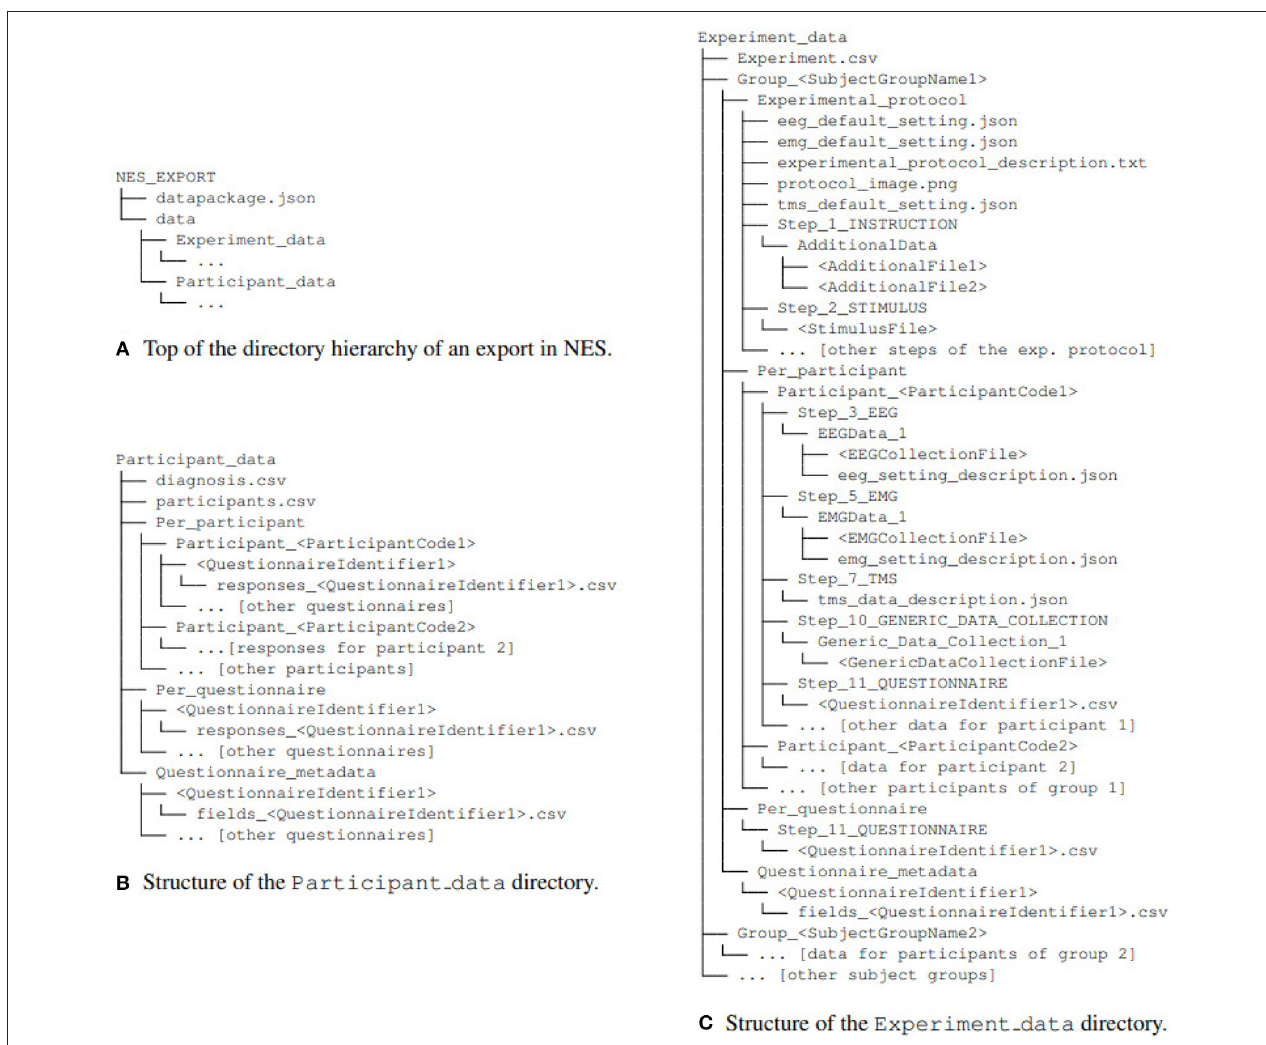
FIGURE 5 | Directory structure of an experiment dataset exported from NES (adapted from Peschanski et al., 2020). The root directory (A) , NEX_EXPORT , contains the directory data , with the data package files, and the file datapackage.json , which describes the structure and contents of the data package (as prescribed by the Frictionless Data standard). The experiment data is organized in two directories: Participant_data (B) and Experiment_data (C) . The former contains the data from the participants (including their responses for questionnaires applied outside the context of experiments), while the latter contains all data collected within the steps of the experimental protocol (and their